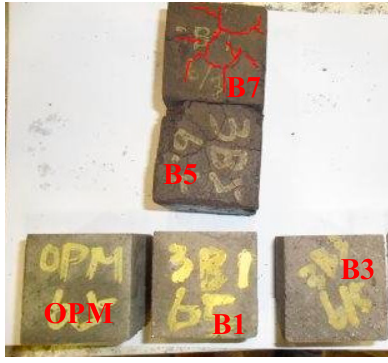
Figure 10. Image of OPM, B1, B3, B5 and B7 specimens.